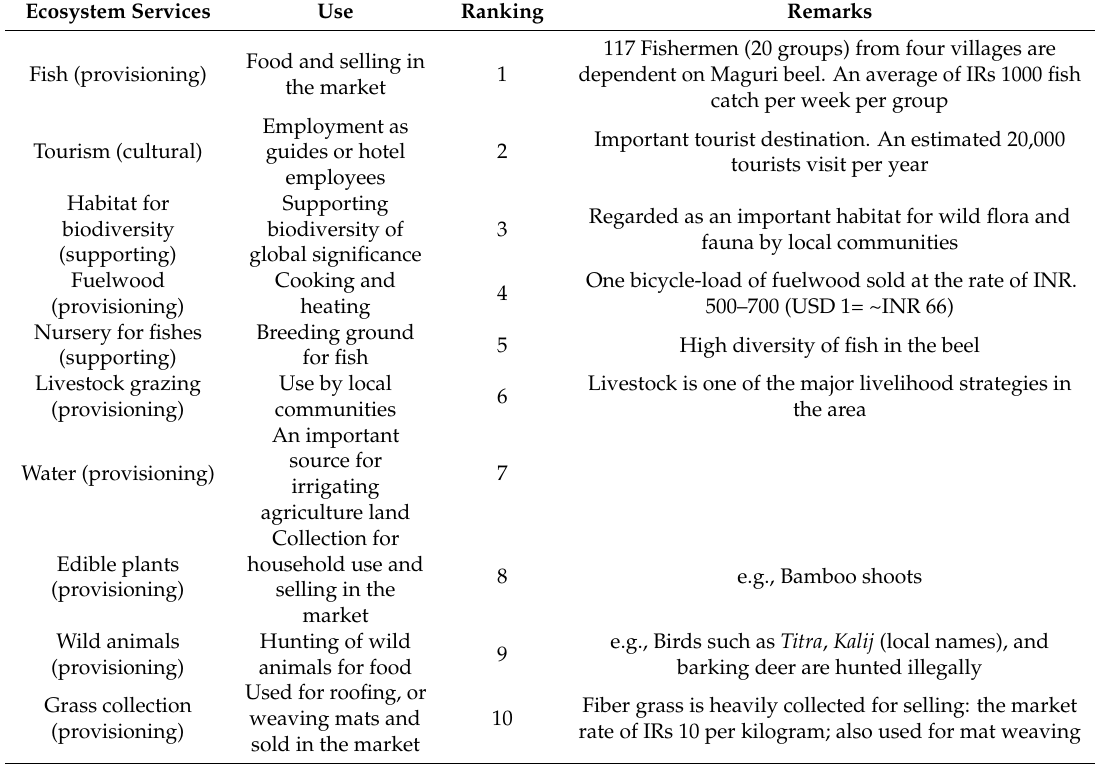
Table 3. Ecosystem services, their use and ranking by local communities (Lower number indicates higher preference). Source: Focus Group Discussion,